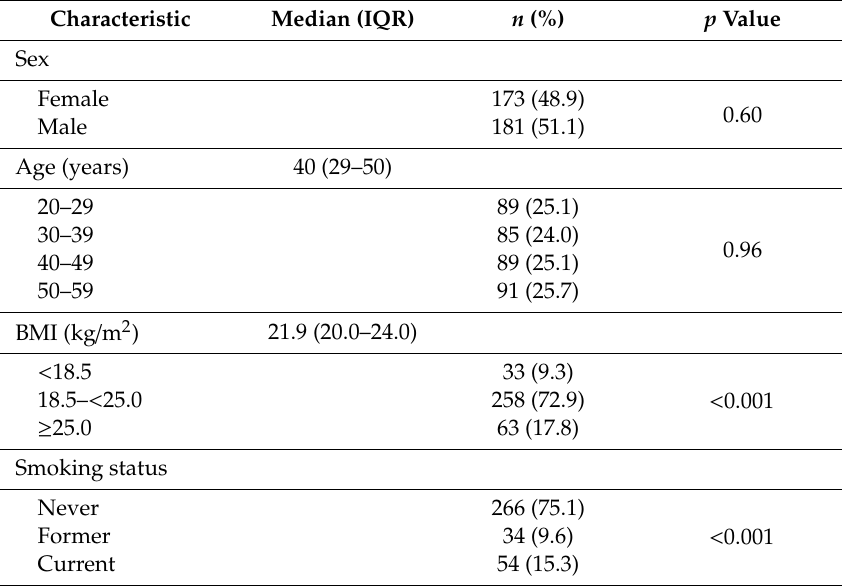
Table 1. Characteristics of the subjects in this study.